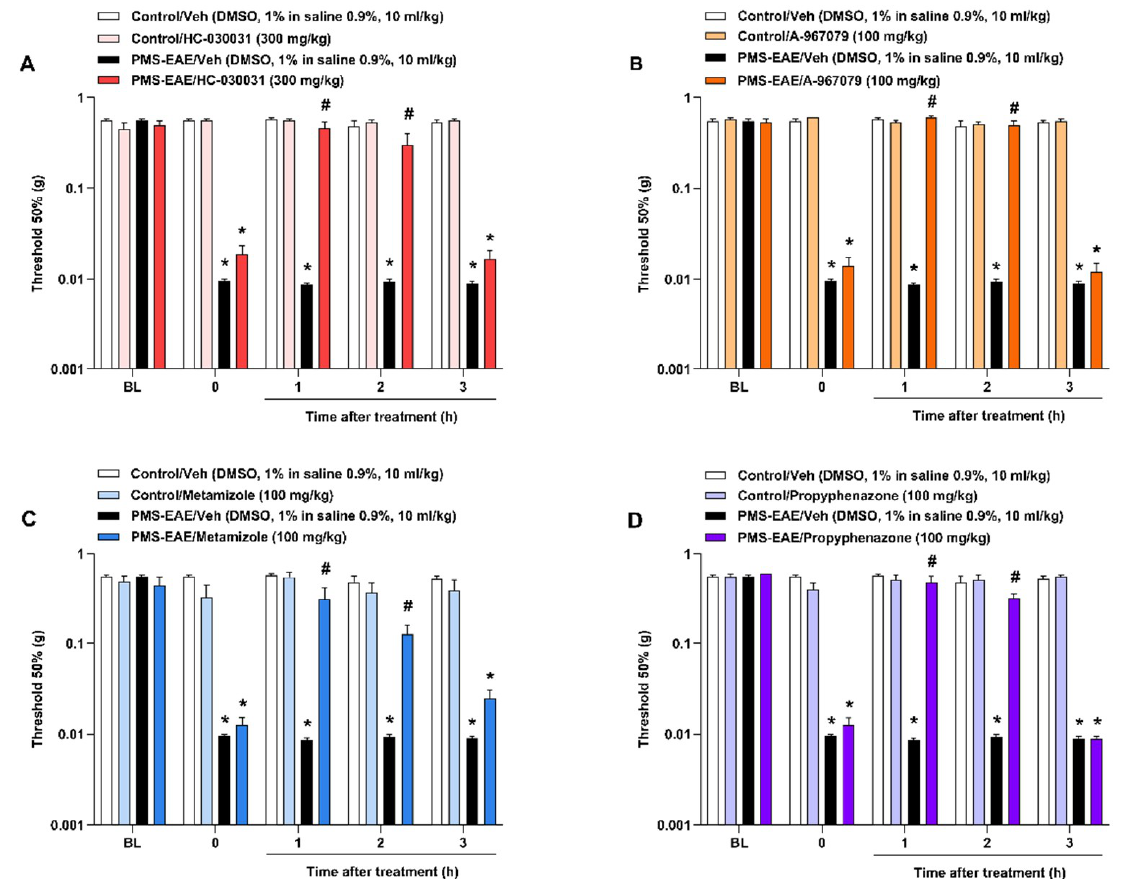
Figure 2. TRPA1 antagonists attenuated periorbital mechanical allodynia (PMA) in the progressive multiple sclerosis model induced by experimental autoimmune encephalomyelitis (PMS-EAE) in mice. All drugs were administered on day 14 post-induction (p.i.), and antinociceptive effects were observed from 1 up to 3 h after intragastric (i.g.) treatment. ( A ) HC-030031 (300 mg/kg), ( B ) A-967079 (100 mg/kg), ( C ) metamizole (100 mg/kg), and ( D ) propyphenazone (100 mg/kg) were tested for PMA induced by PMS-EAE. The vehicle group received dimethyl sulfoxide (DMSO) 1% in isotonic saline 0.9% by i.g. administration. Baseline values (BL) were observed before PMS-EAE induction. Data are expressed as mean + SEM ( n = 6–8) in the graphs. * p < 0.05, when compared to the control group or baseline values; # p <0.05, when compared to the group treated with the PMS-EAE vehicle group (Two-way ANOVA, followed by the Bonferroni post hoc test).